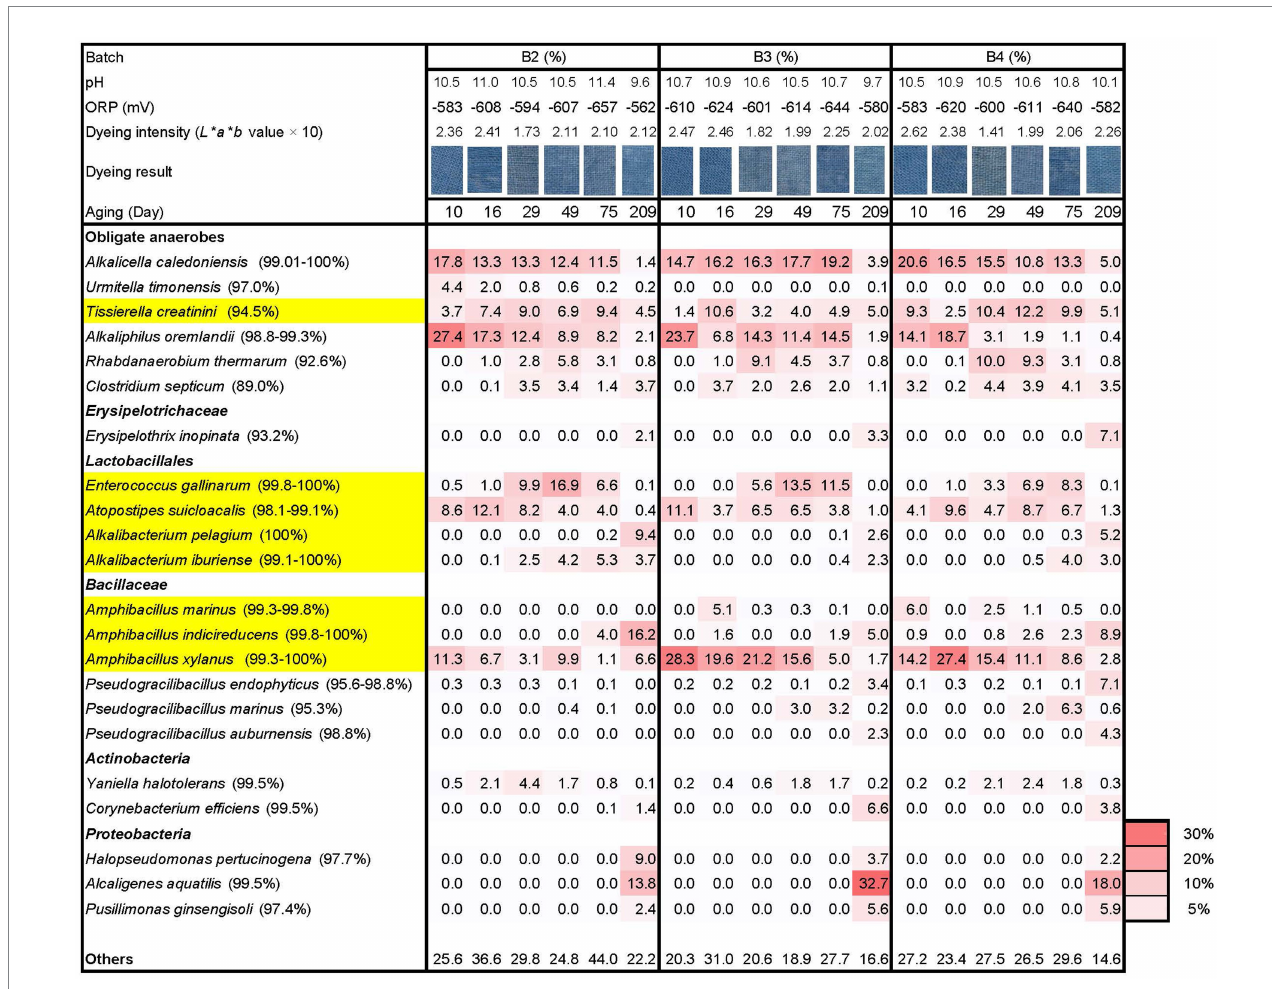
FIGURE 3 Changes in the relative abundance (%) of bacterial communities ( ≥ 4.1% in any sample) based on 16S rRNA analysis, dyeing intensity (dyeing result and L * a * b * value), ORP, and pH during days 10–209 following different initial treatments of sukumo . B2: batch 2 ( sukumo treated with 25 ° C tap water [control]); B3: batch 3 ( sukumo treated with 25 ° C wood ash extract); B4: batch 4 ( sukumo treated with 60 ° C wood ash extract). Yellow marked taxa indicate the confirmed indigo-reducing taxa (including unpublished results). The percentages in the brackets indicate the similarities with the top hit taxa as revealed via a BLAST (blastn) search in